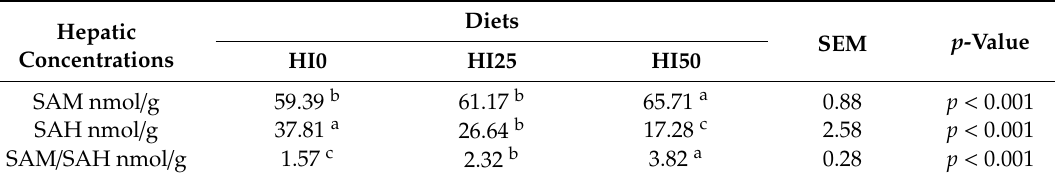
Table 2. Liver concentrations of SAM and SAH and the SAM/SAH ratio measured in rainbow trout (n = 8). Different letters in the same row indicate statistically significant differences ( p < 0.05): one-way ANOVA followed by Tukey's test.